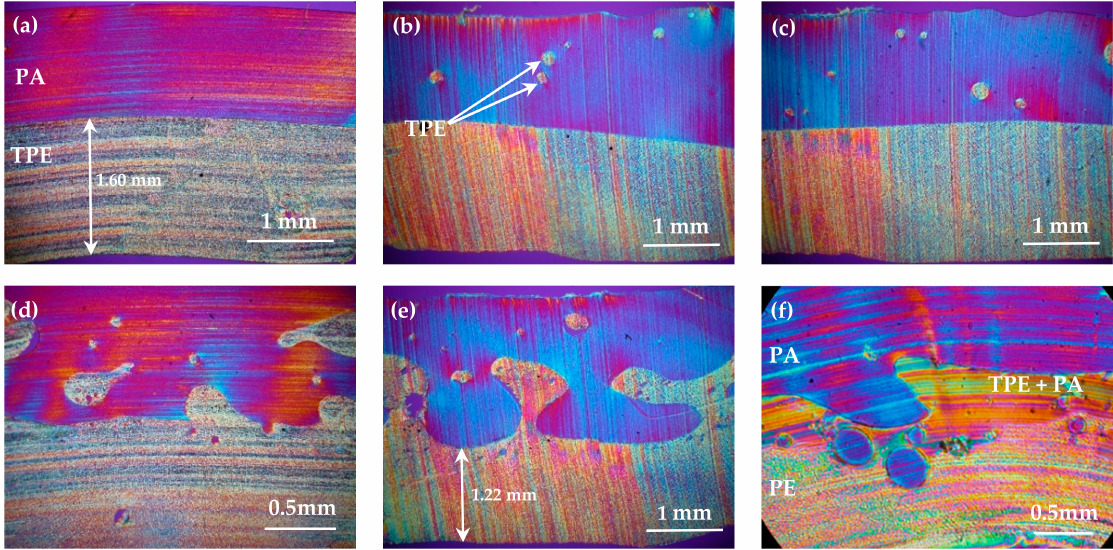
Figure 6. Pictures of cross-sections in polarized microscopy ( a ) plasma-treated polyethylene (TPE)/polyamide (PA); ( b ) TPE/PA*4; ( c ) TPE/PA*3; ( d ) TPE/PA*2.5, ( e ) TPE/PA*2; ( f ) PE/TPE +